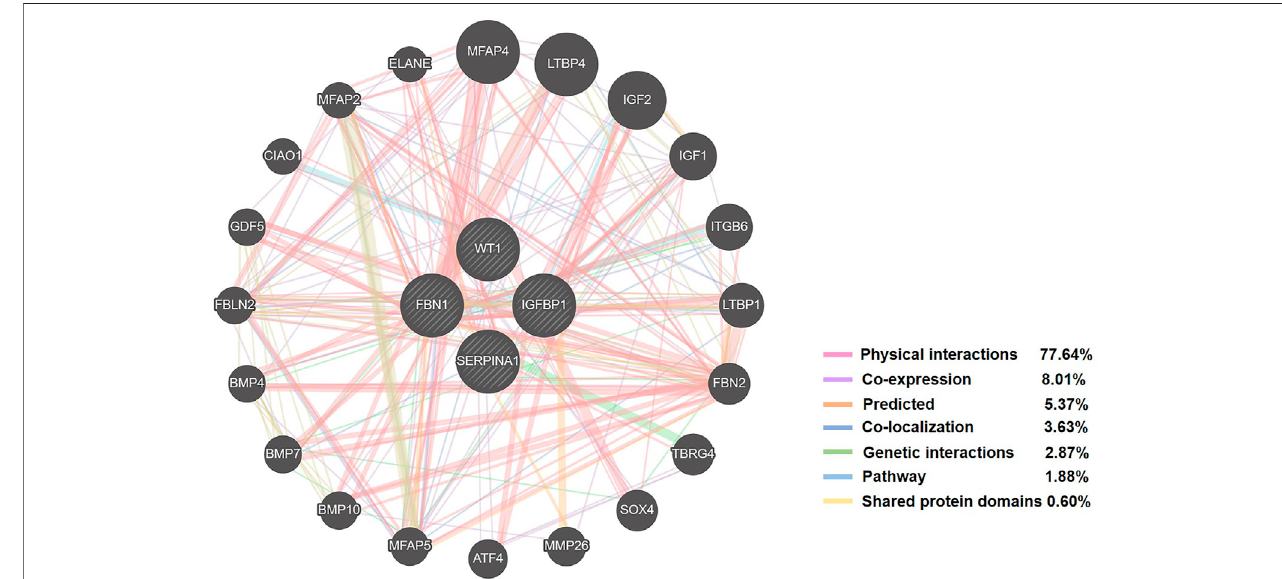
FIGURE 7 | The network of WT1, IGFBP1, FBN1, SERPINA1 and related genes constructed by GeneMANIA.